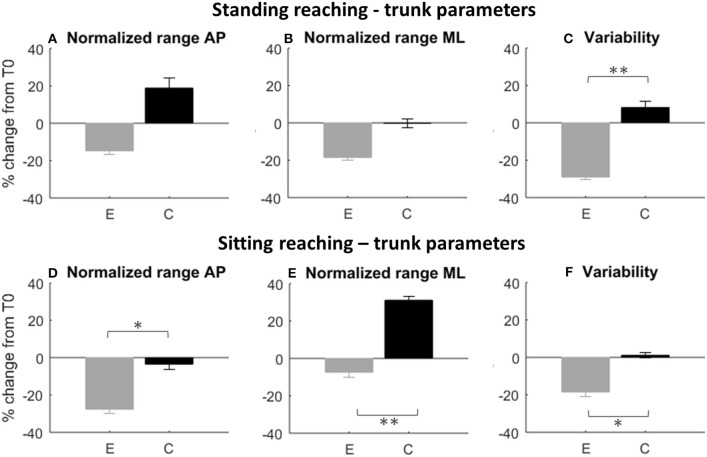
Rate of improvement T0-T1 for the proprioceptive control test. Trunk oscillation changes during the reaching task in standing (first row) and sitting (second row) position are represented. E, experimental group; C, control group. (A–D) Anteroposterior (AP) oscillatory range of the trunk; (B–E): mediolateral (ML) oscillatory range of the trunk; (C–F): standard deviation of the trunk acceleration. Error bars indicate standard error; * indicate a p-value between 0.01 and 0.05, while ** indicate p < 0.01.